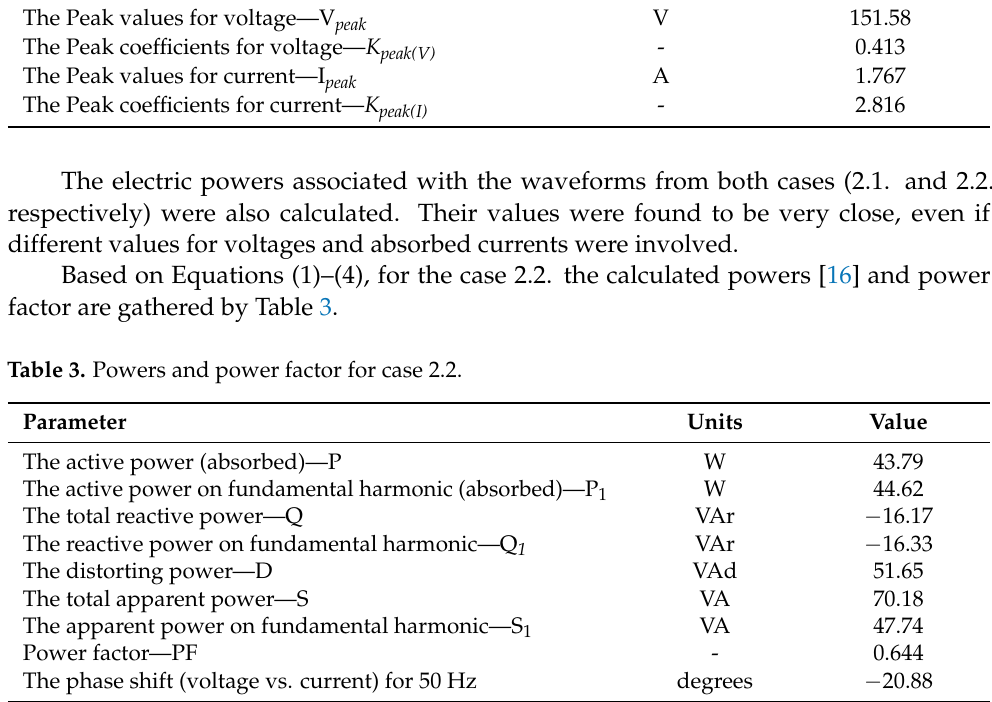
Table 2. Power quality parameters and indices for the recorded electric quantities for case 2.2.